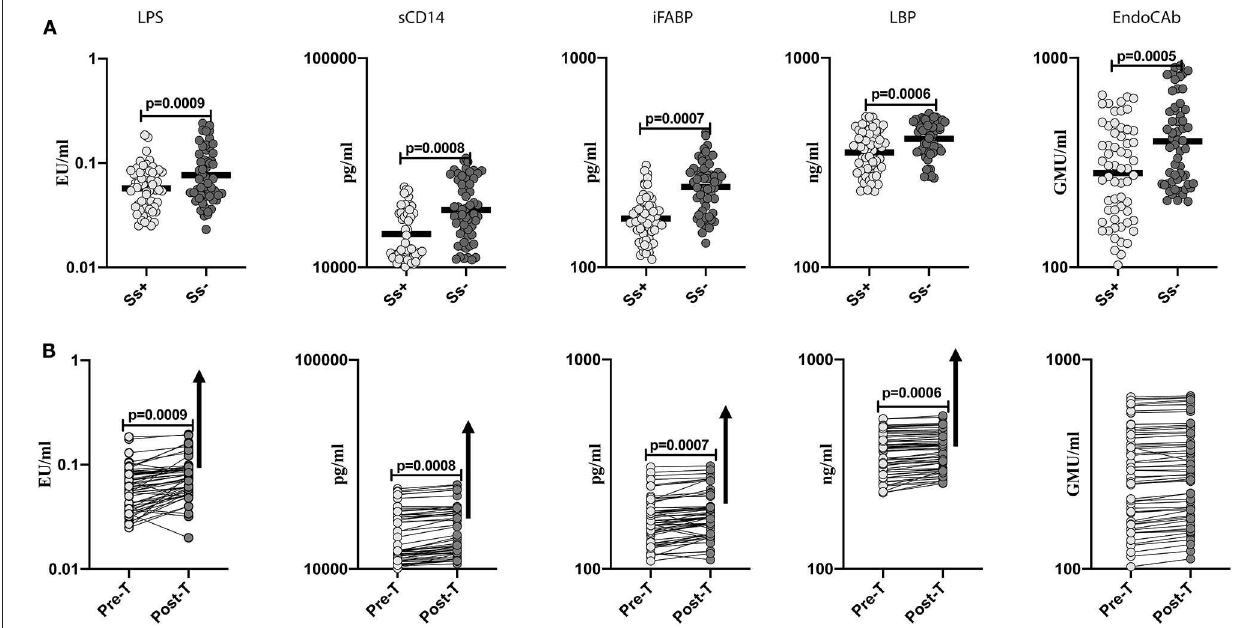
FIGURE 2 | Diminished systemic levels of microbial translocation markers in helminth-diabetes comorbidity and partial reversal after anthelmintic treatment. (A) Plasma levels of lipopolysaccharide (LPS), soluble CD14 (sCD14), intestinal fatty acid binding protein (iFABP), lipid binding protein (LBP), and endotoxin core antibody IgG (EndoCAb), from Ss infected [ Ss + ] ( n = 60) or uninfected [ Ss − ] ( n = 58) individuals were measured by ELISA. Data are shown as scatter plots with the bar representing the geometric mean. p -values were calculated using the Mann-Whitney U-test with Holms correction for multiple comparisons. (B) Plasma levels of lipopolysaccharide (LPS), soluble CD14 (sCD14), intestinal fatty acid binding protein (iFABP), lipid binding protein (LBP), and endotoxin core antibody IgG (EndoCAb) from Ss -infected individuals at pre-treatment [pre-T] ( n = 60) and at 6 months following treatment [post-treatment (post-T)] were measured by ELISA. The arrow shows the directionality of the significance. p -values were calculated using the Wilcoxon matched pair